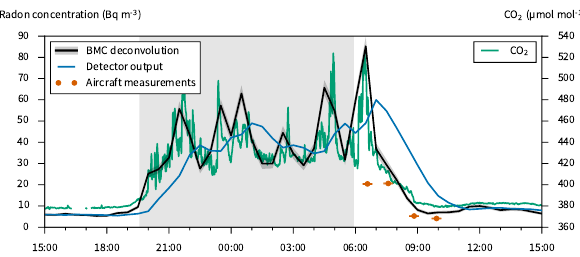
Figure 7. Field observations from a calm and clear night on the 5th–6th of November 2011. The wind speed was (cid:46) 1ms − 1 at 2ma.g.l. for most of the night. Aircraft measurements were made 36–41m.a.g.l. over 6km flight segments. Night-time is shaded grey, as is the 16th–84th percentile range about the reconstructed time